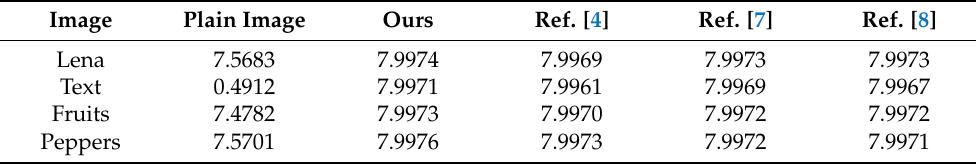
Table 4. Information entropy test results of cipher Table 3. Information entropy test results of scrambled intermediate cipher image.